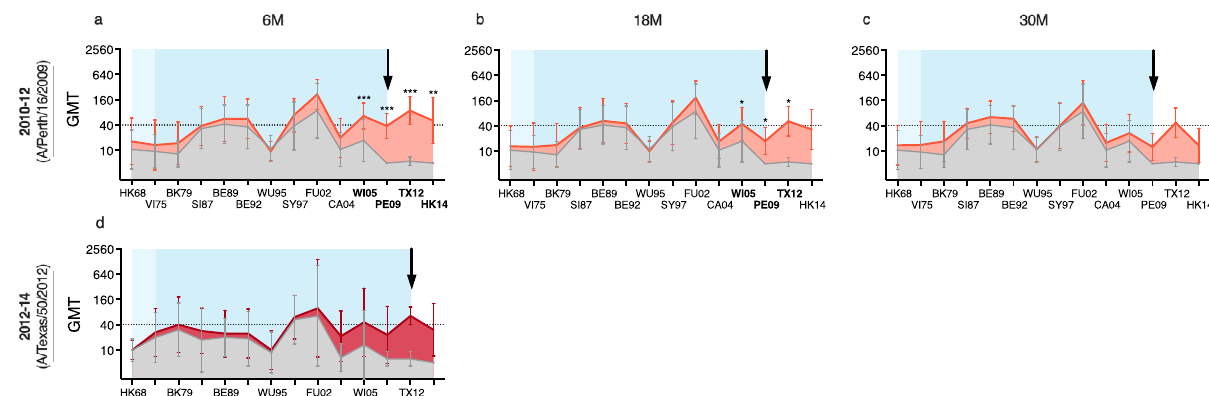
Fig. 3 Hemagglutination inhibition (HI) antibody landscapes after A/H3N2 infection in adults. Antibody landscapes were generated with geometric mean HI titres (GMTs) against 14 historical and future in fl uenza A/H3N2 viruses (see Table 1 for the strains used). Error bars represent the 95% con fi dence intervals of the GMTs. In Norway, the in fl uenza season usually starts at the end of October and peaks between December and March. Blood samples were collected annually in September/October from 2010 to 2014 from unvaccinated adults. Seroconversion (four-fold increase in HI titres) between two time points against the predominantly circulating A/H3N2 viruses were de fi ned as infection. The time post-infection was calculated from the season seroconversion occurred. All individual landscapes are shown in Supplementary Figure 2a. HI antibody landscapes are shown pre-infection (grey) and at 6-9 months (6 M) ( a ), 18 – 21 months (18 M) ( b ) and 30- 33 months (30 M) ( c ) post-infection with PE09, n = 7, and at 6-9 months post-infection with TX12, n = 5 ( d ). No landscape was generated at 18- 21 months post-TX12 infection because only 2 individuals provided serum samples. The viral exposure period is shown in blue based on the group ’ s median age, and in light blue indicating the oldest individual in the group. Pre- and post-infection HI titres were compared using non- parametric repeated measure Friedman test with Dunn ’ s multiple comparison correction for each infected group. * P < 0.05, ** P < 0.01, *** P = <